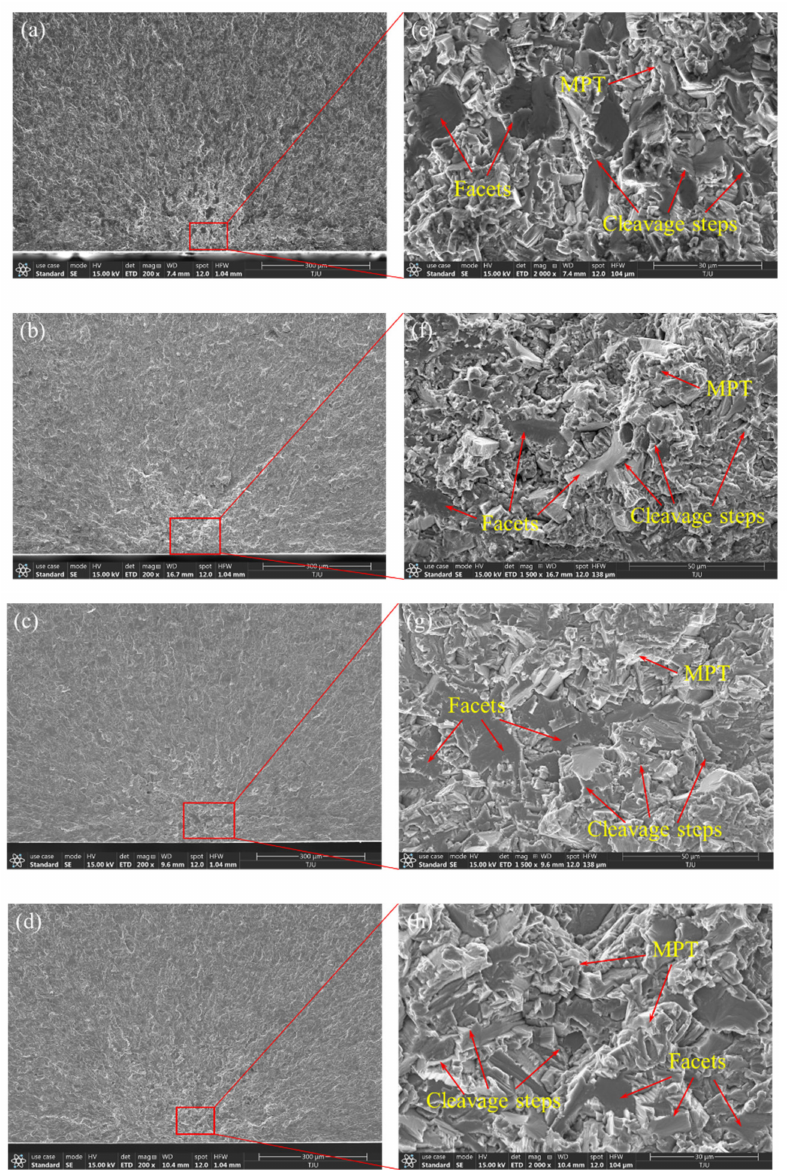
Figure 8. SEM morphology of ultra-high-cycle-fatigue crack origin zone. ( a , e ) Equiaxed I, × 10 8 ; ( b , d ) equiaxed II, σ a = 233 MPa, N σ a = 218 MPa, N f = 6.06 I, σ a = 225 MPa, N f = 4.15 × 10 8 ; ( g , h ) bimodal II, σ a = 233 MPa, N f = 3.25 × 10 8